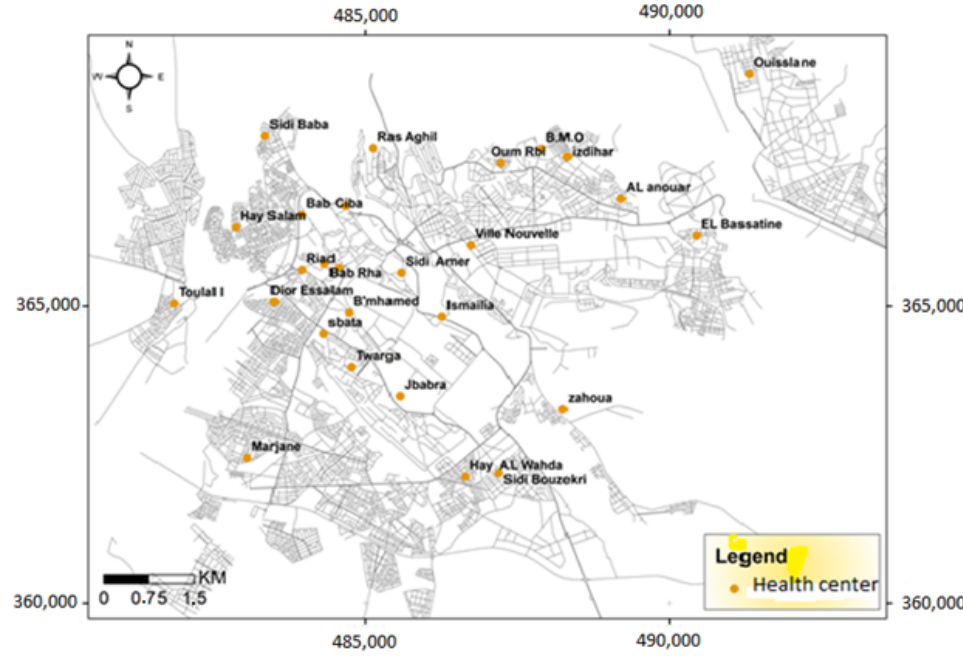
Figure 4. Location of health structures in the city of Meknes.